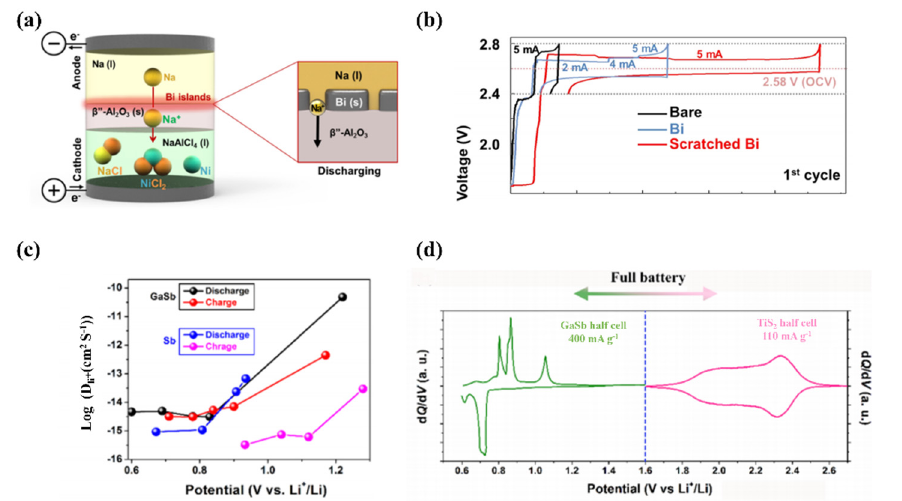
Figure 6. ( a )Schematic of the Na/NiCl2 cell ( b ) Voltage profiles of the initial cycle of bare, Bi ‐ coated, and scratched Bi ‐ coated β″‐ Al 2 O 3 cells. Reprinted with permission from Ref. [86] Copyright 2019 ACS Applied Materials & Interfaces . ( c ) Li ‐ ion diffusion coefficients for GaSb and Sb electrodes at selected states ( d ) Typical dQ/dV curves of GaSb and TiS 2 electrodes. Reprinted with permission from Ref. [87] Copyright 2020 ACS Applied Materials & Interfaces.